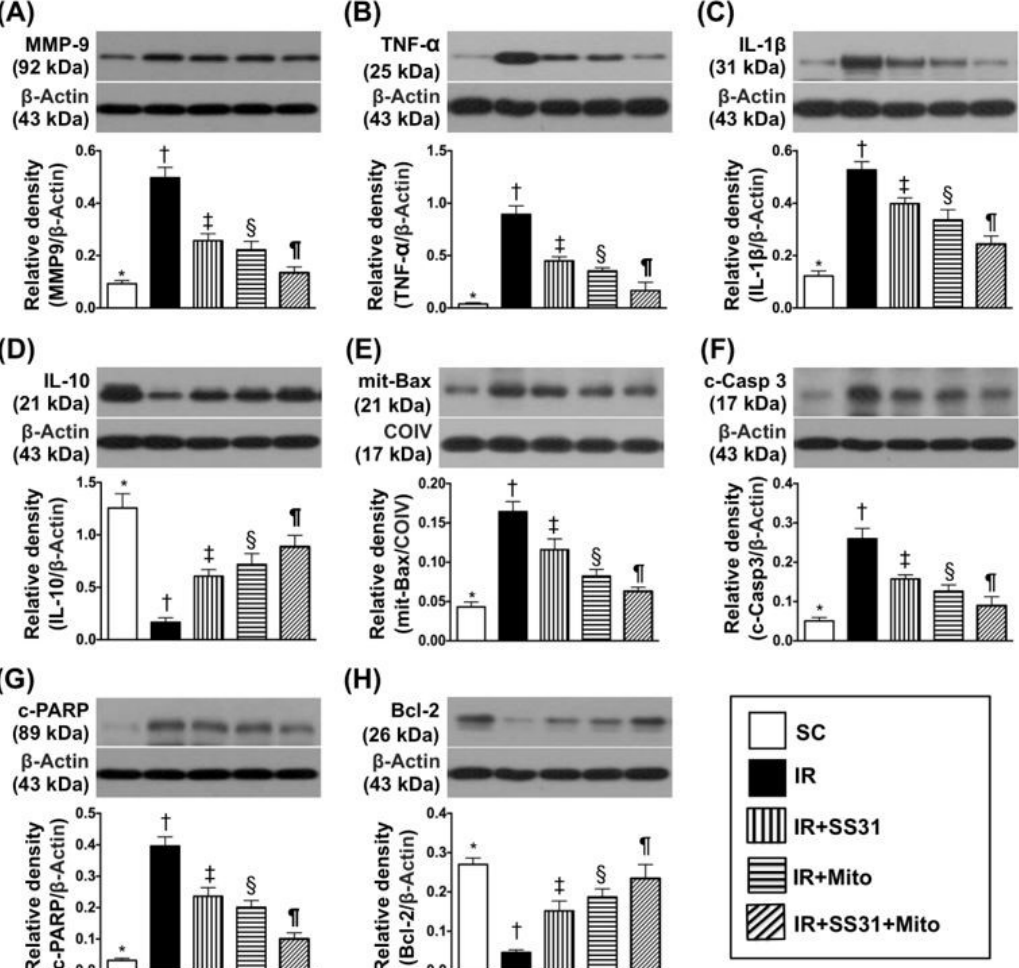
Figure 6. Pro-inflammatory, anti-inflammatory, apoptotic, and anti-apoptotic biomarkers in LV myocardium IR procedure. ( A ) Protein expression of matrix metalloproteinase (MMP)-9 * vs. other groups with different symbols (†, ‡, §, ¶), p < 0.0001. ( B ) Protein expression of tumor necrosis factor (TNF)- α * vs. other groups with different symbols (†, ‡, §, ¶), p < 0.0001. ( C ) Protein expression of interleukin (IL)-1ß * vs. other groups with different symbols (†, ‡, §, ¶), p < 0.0001. ( D ) Protein expression of IL-10 * vs. other groups with different symbols (†, ‡, §, ¶), p < 0.0001. ( E ) Protein expression of mitochondrial (mito)-Bax * vs. other groups with different symbols (†, ‡, §, ¶), p < 0.0001. ( F ) Protein expression of cleaved caspase 3 (c-Casp 3) * vs. other groups with different symbols (†, ‡, §, ¶), p < 0.0001. ( G ) Protein expression of cleaved poly (ADP-ribose) polymerase (c-PARP) * vs. other groups with different symbols (†, ‡, §, ¶), p < 0.0001. ( H ) Protein expression of Bcl-2 * vs. other groups with different symbols (†, ‡, §, ¶), p < 0.0001. All statistical analyses were performed by one-way ANOVA, which was followed by the Bonferroni multiple comparison post hoc test ( n = 8 for each group). Symbols (*, †, ‡, §, ¶) indicate significance at the 0.05 level. SC = sham control, IR = ischemia-reperfusion, Mito = mitochondria.